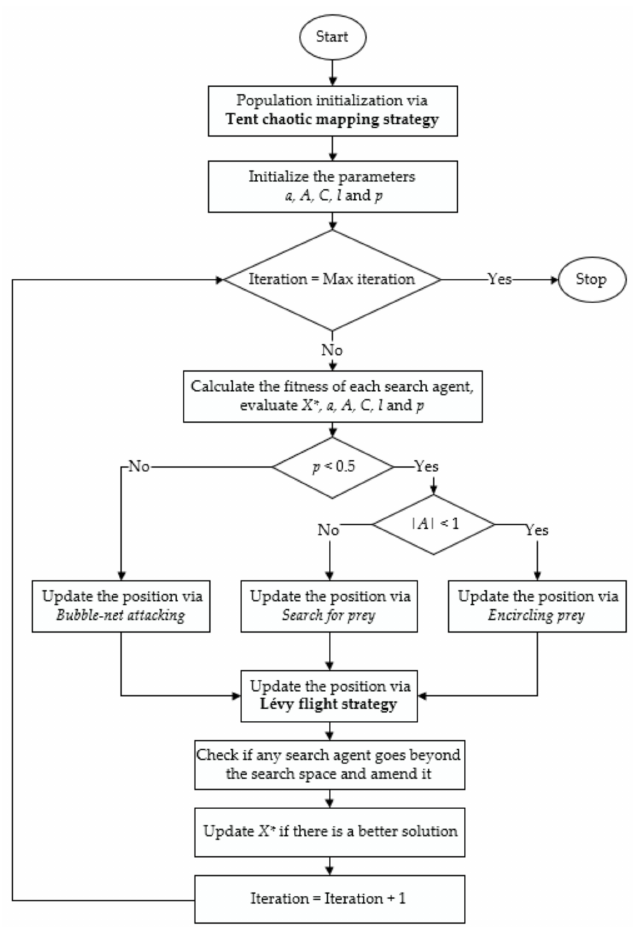
Figure 6. Optimization flowchart of hybrid chaotic whale optimization